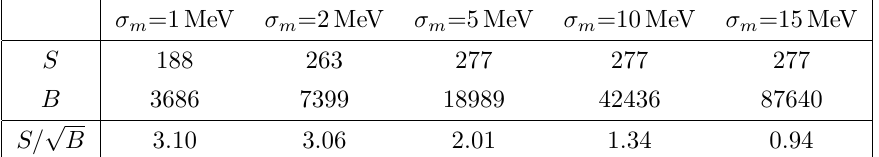
= 10 11 and favoured parameters ε J/ Ψ